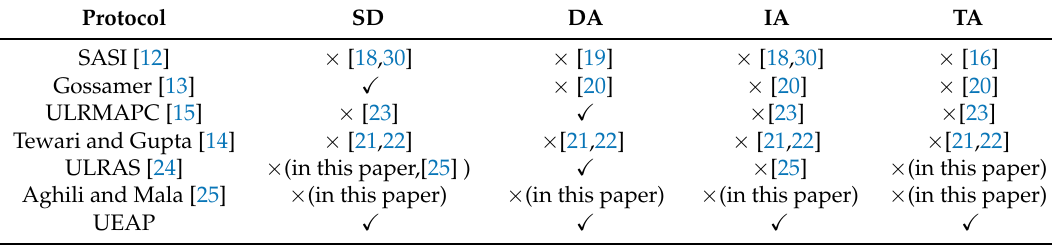
Table 3. Security comparison of the UEAP protocol with other protocols, where SD, DA, IA, TA, (cid:88) and × denote Secret Disclosure Attack, De-synchronization Attack, Impersonation Attack, Traceability Attack, Secure and Vulnerable